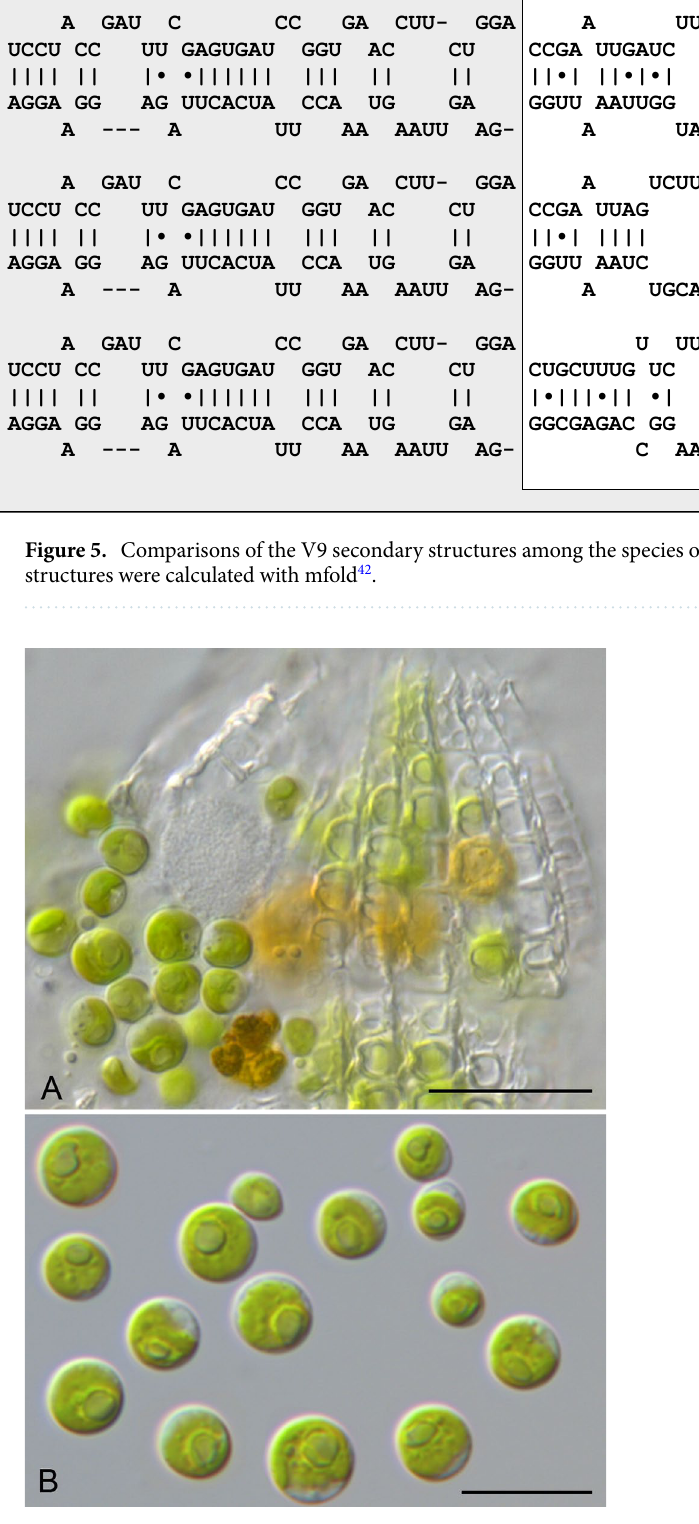
Figure 6. Morphology and phenotypic plasticity of Micractinium conductrix . ( A ) from a squeezed cell of Coleps viridis , strain CIL-2017/13, ( B ) isolated strain CCAP 248/20; scale bar = 10